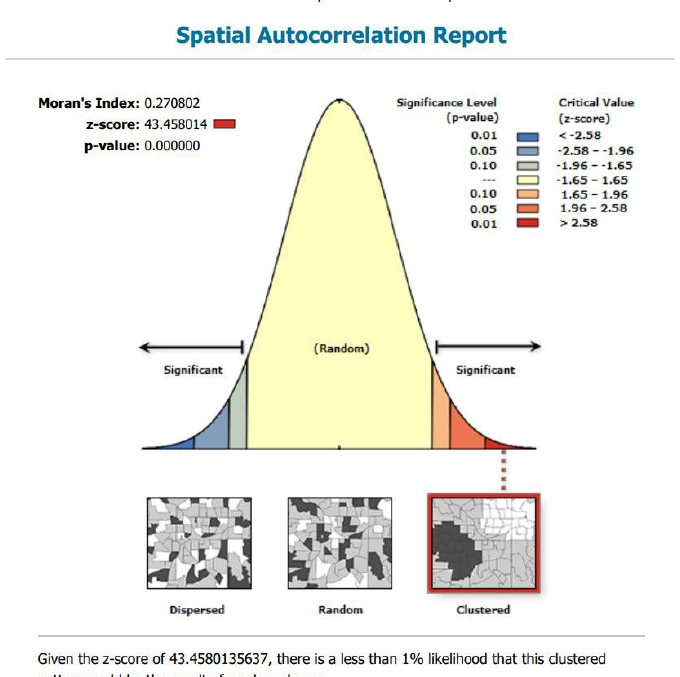
Fig. 3 Spatial autocorrelation report (Global Moran